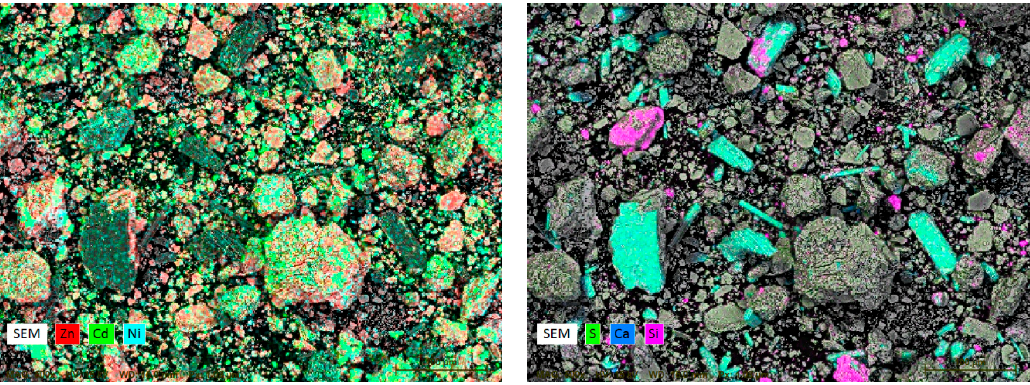
Figure 2. SEM micrograph with overlaid EDX (Energy Dispersive X-ray Spectroscopy) mapping of Ni-Cd cake waste